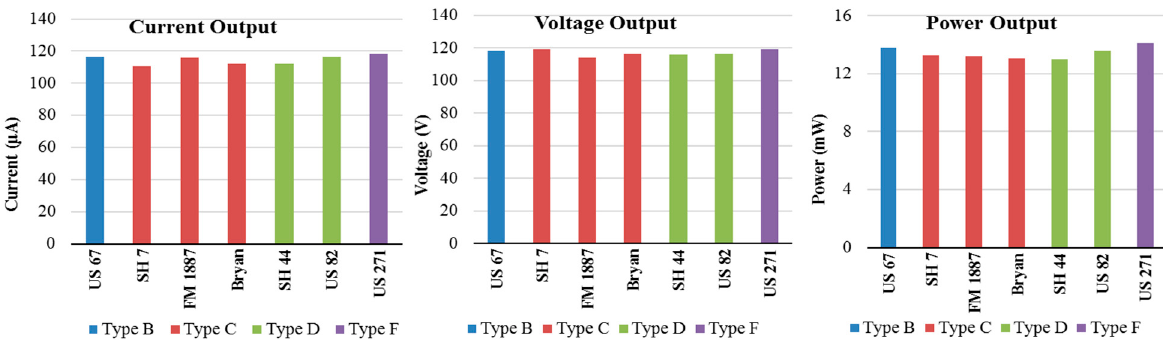
Figure 10. UTM-HiSEC Energy Generation HMA Variation (1 Hz, 20